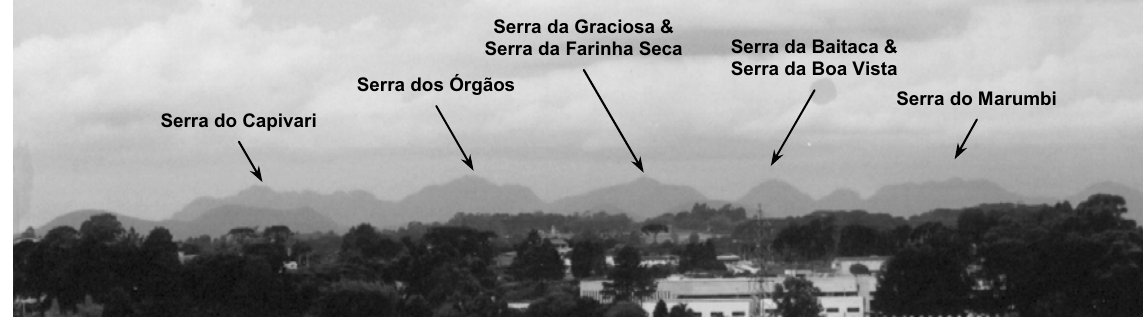
Fig. 3 – Panoramic view of the Serra da Graciosa region in eastern Paraná State, southern Brazil. The photo was taken from the highway BR-116 in the vicinities of the city of Curitiba. View is to the